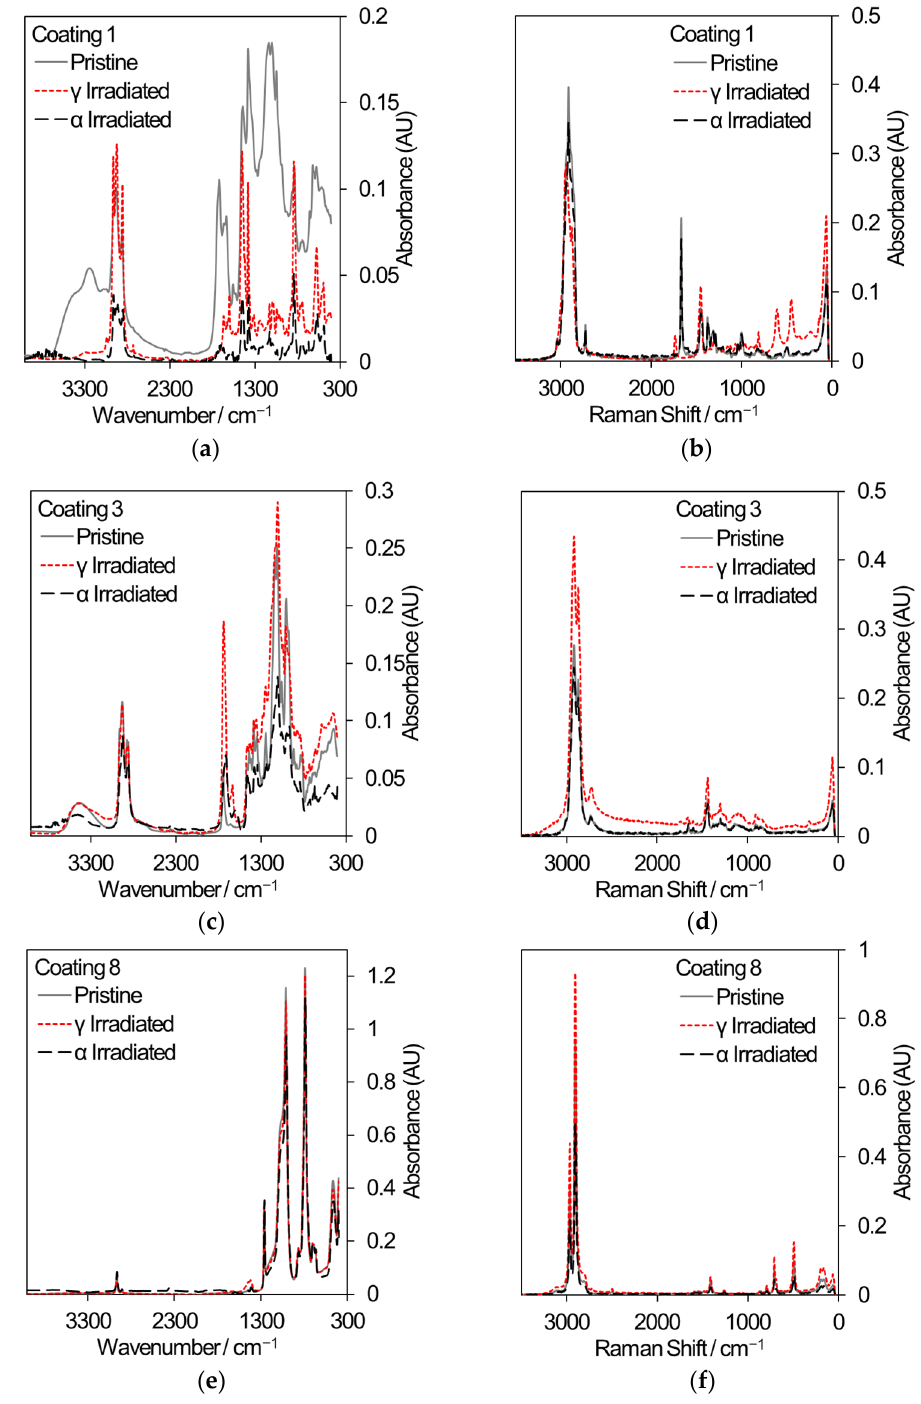
Figure 9. FT-IR and Raman spectra from a selection of commercial strippable decontamination coatings that received an absorbed dose of 500 kGy from either gamma radiation or He ions. ( a ) FT-IR spectra from coating 1. ( b ) Raman spectra from coating 1. ( c ) FT-IR spectra from coating 3. ( d ) Raman spectra from coating 3. ( e ) FT-IR spectra from coating 8. ( f ) Raman spectra from coating 8.